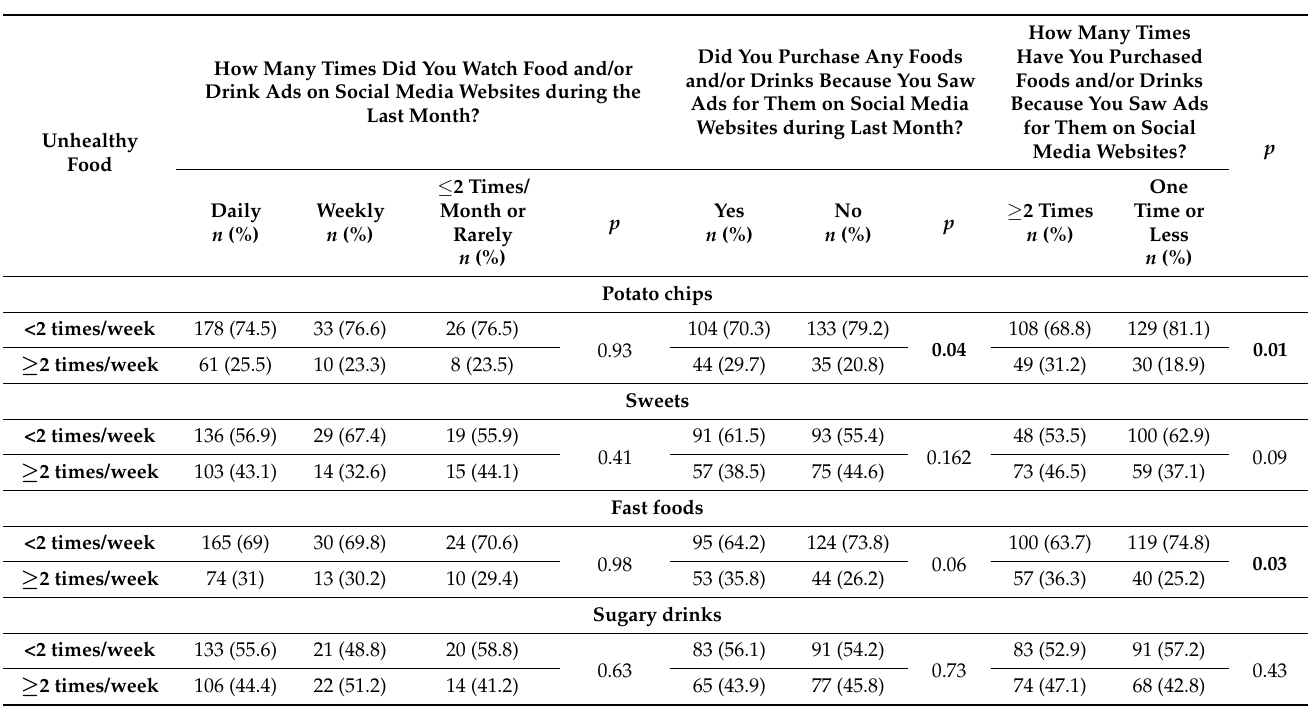
Table 4. Exposure to food marketing via social media websites and its association with unhealthy food intake among the study participants.